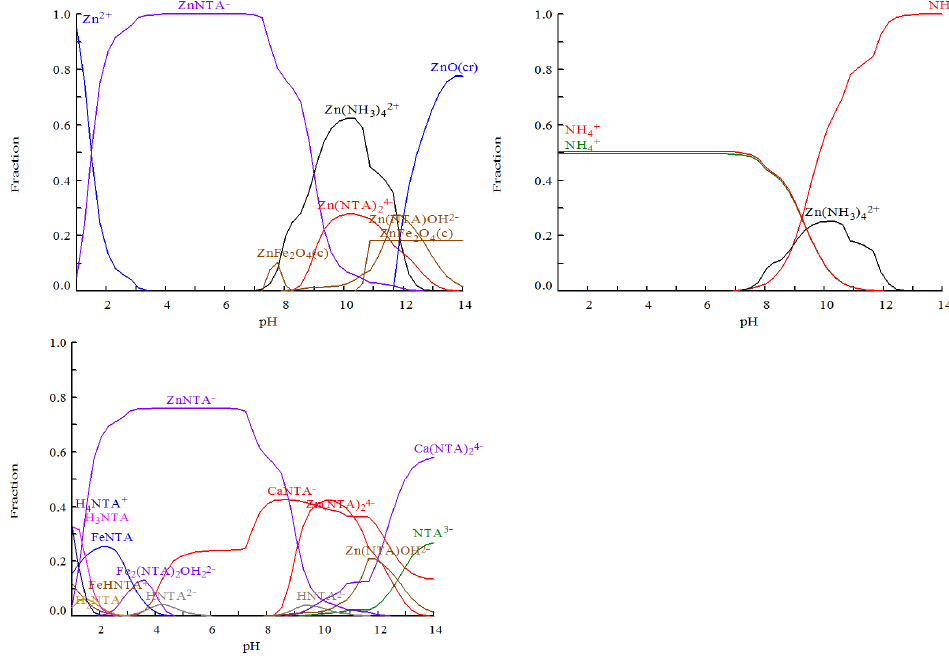
Figure 10. The effect of NTA 3 − on Zn (II) species, NTA 3 − species and NH 3 species distribution diagrams in the solution. The diagram is made by the authors in Medusa software version 2010.